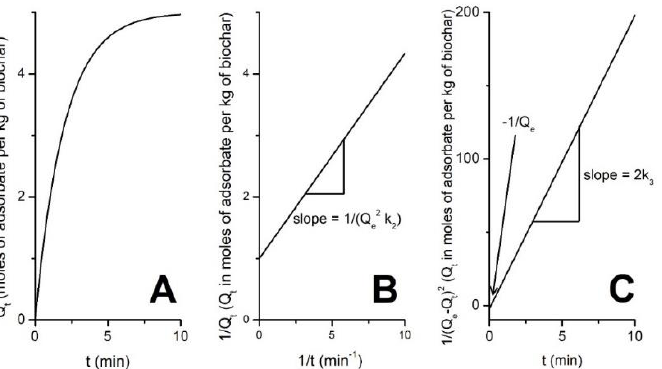
Figure 12. Simulation curves for the pseudo − first order ( A ), pseudo − second order ( B ), and pseudo − third order ( C ) absorption kinetics on biochar. The simulations have been performed by using Origin Pro 7.5.